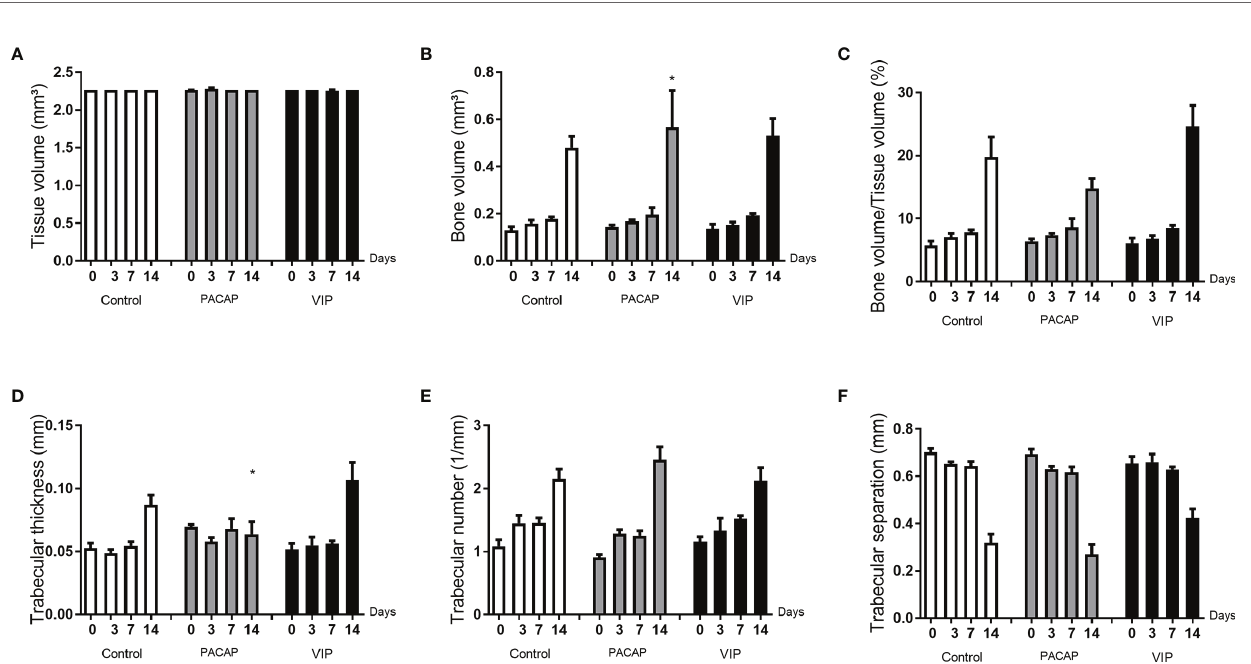
FIGURE 14 | Analysis of the morphological parameters of the trabecular bone microarchitecture in the dental alveoli of the control mice and treated with PACAP and VIP in the 0, 3-, 7-, and 14-day post-exodontia periods. The morphological parameters of the bone microarchitecture were evaluated using the CTAn software through a cylindrical region of interest (ROI) determined by the segmentation of the trabecular bone located from the coronal to the apical region. The analysis of bone parameters (A – F) included: Tissue volume (mm 3 ) (A) , Bone volume (mm 3 ) (B) , Bone volume in relation to tissue volume (%) (C) , Trabeculae thickness (mm) (D) , Number of trabeculae (1/mm) (E) , and Separation of trabeculae (mm) (F) . The results represent the values of the mean and standard deviation in each of the periods analyzed (* represents the differences between the control